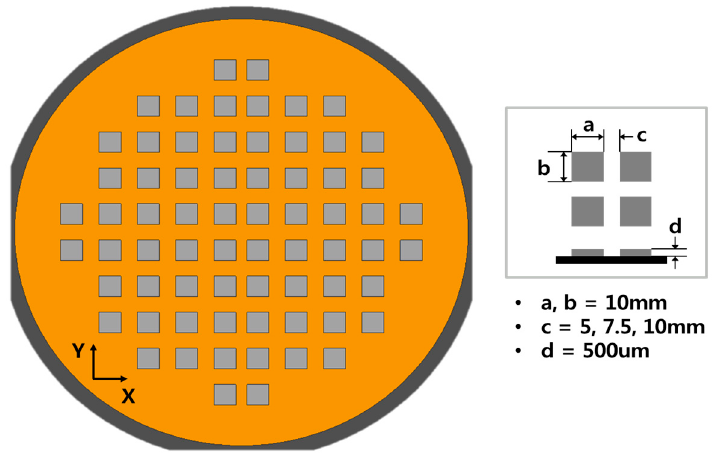
Figure 6. Design specifications of the wafer-level package (a: X -axis length of die; b: Y -axis length of die; c: die gap (gap between adjacent dies); d: die thickness).